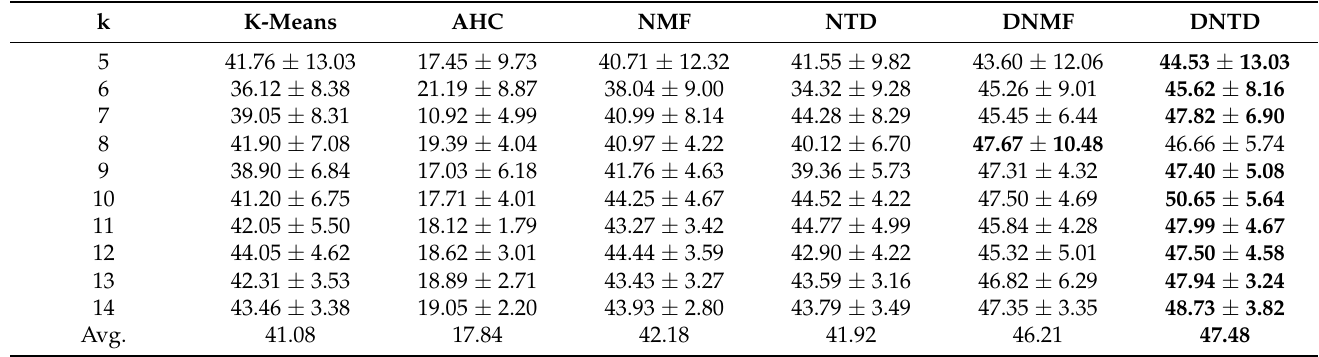
Table 6. NMI (%) ± standard deviation (%) of different algorithms on Yale